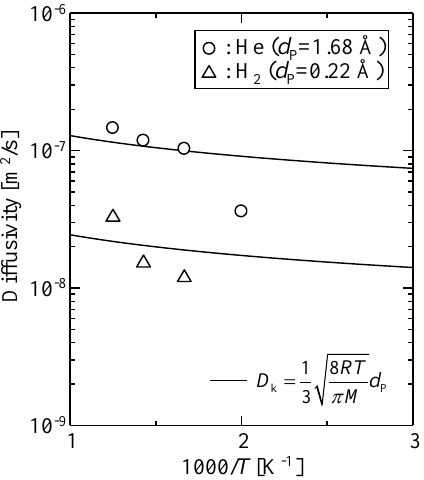
Figure 10. Diffusivities obtained from gas permeation simulations for a virtual amorphous silica membrane model.